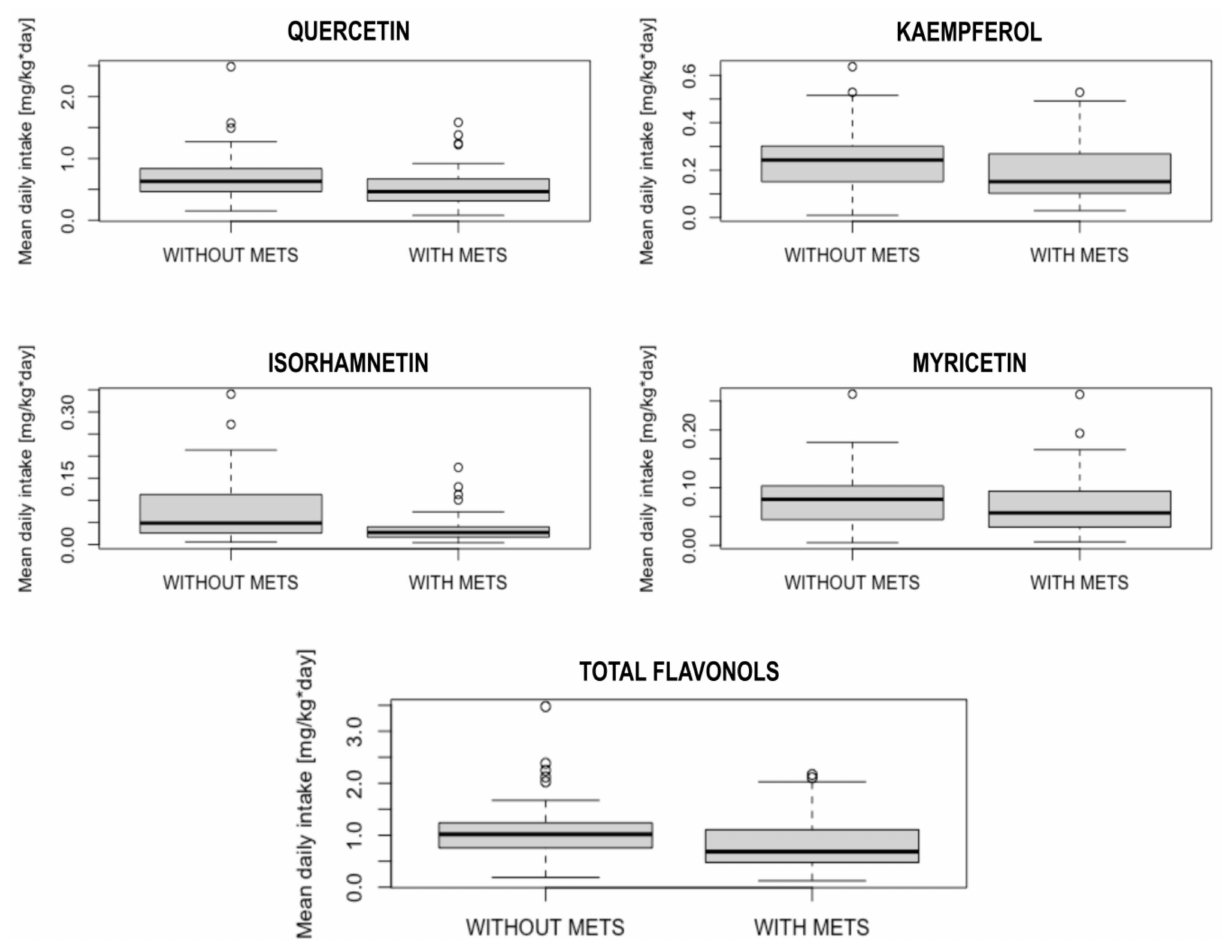
Figure 1. Box-plots presenting the differences in flavonols intake between patients with and without MetS diagnosis. (MetS—metabolic